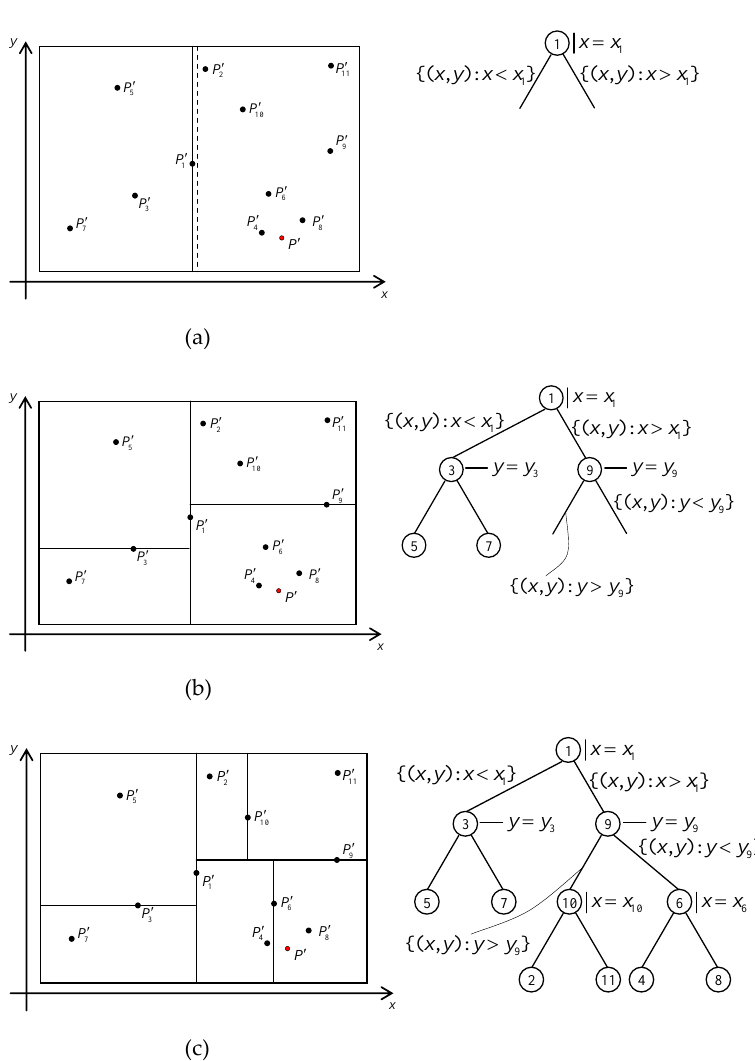
including the point is divided into rectangular sub-areas in order, as presented in Figure 10. Figure 10.